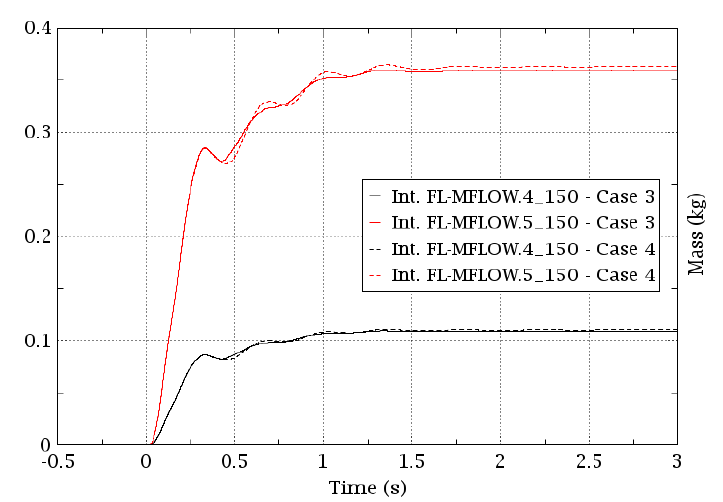
Figure 4. Total mass of N 2 (red color) and O 2 (black color) reaching the TVC volume, 0.05 m 2 break downstream FIV. Case 3: vacuum system closed in coincidence with the break; Case 4: VS closed 1.5 s later; Int. FL-MFLOW.X_150 means ‘integrated mass flow through flow path 150 of the MELCOR model’, index X = 4 for O 2 , X = 5 for N 2 .